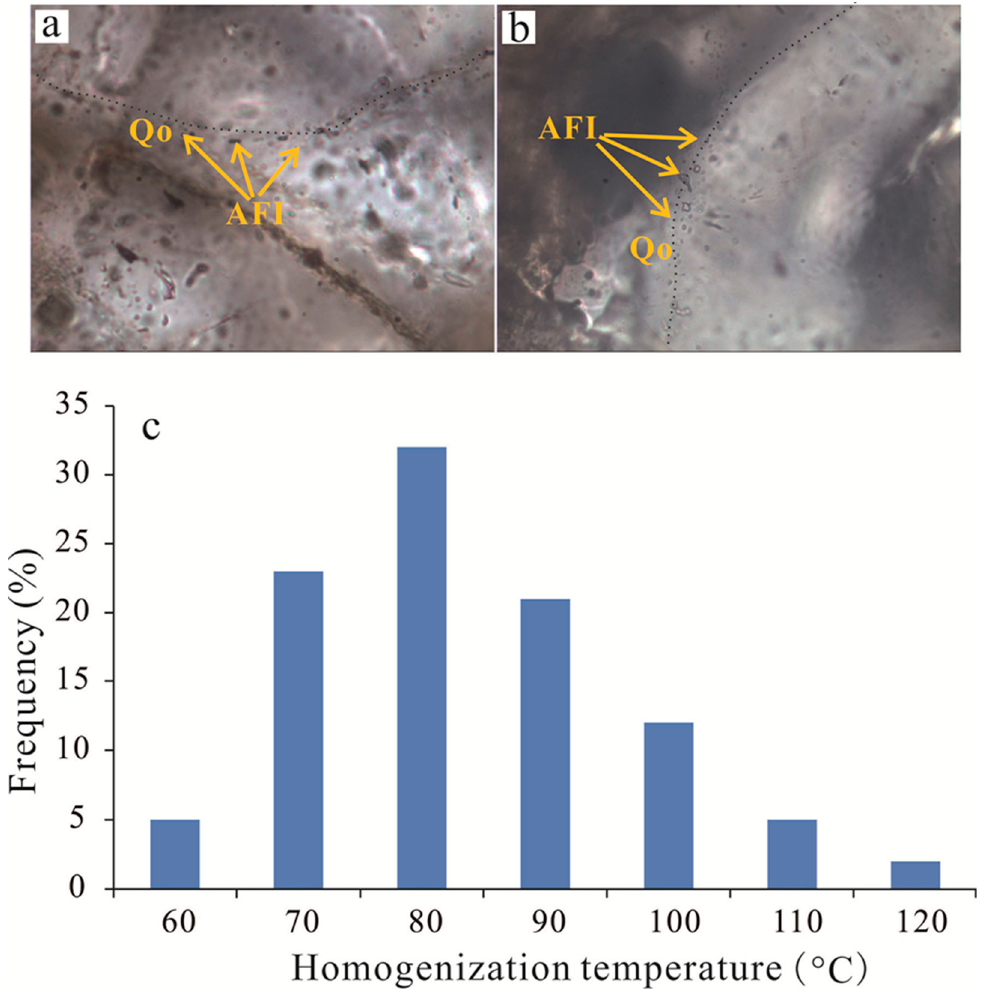
Figure 13. ( a ) and ( b ) Photomicrographs of aqueous fluid inclusions (AFI) in quartz overgrowth (Qo). ( c ) Histograms of homogenization temperatures (Th) of aqueous inclusions in quartz overgrowths in Lulehe sandstone reservoirs.